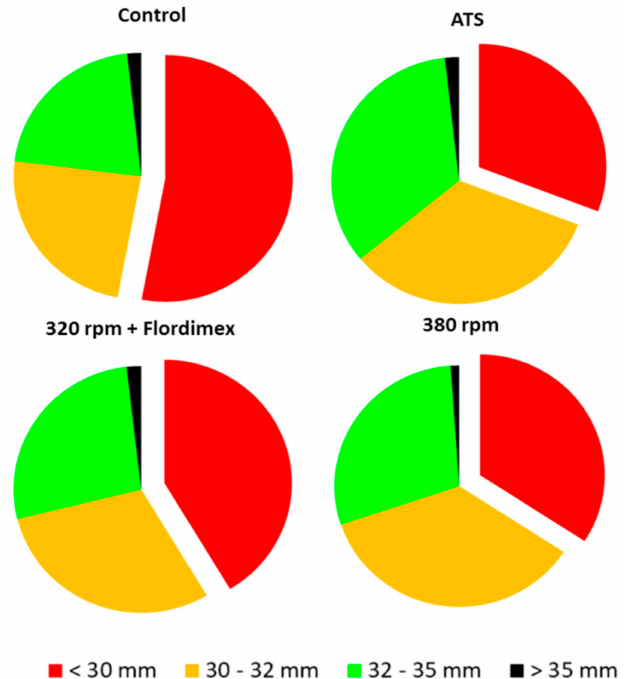
Figure 5. Relative proportions of fruit sizes and quality, as a ff ected by mechanical and chemical thinning, in the European plum cv. “Ortenauer” in Grafschaft in 2013; unmarketable fresh fruit, < 30 mm, in red; small, 30–32 mm, in orange; medium-sized fruit, 32–35 mm, in green; and large fruit, > 35 mm, in